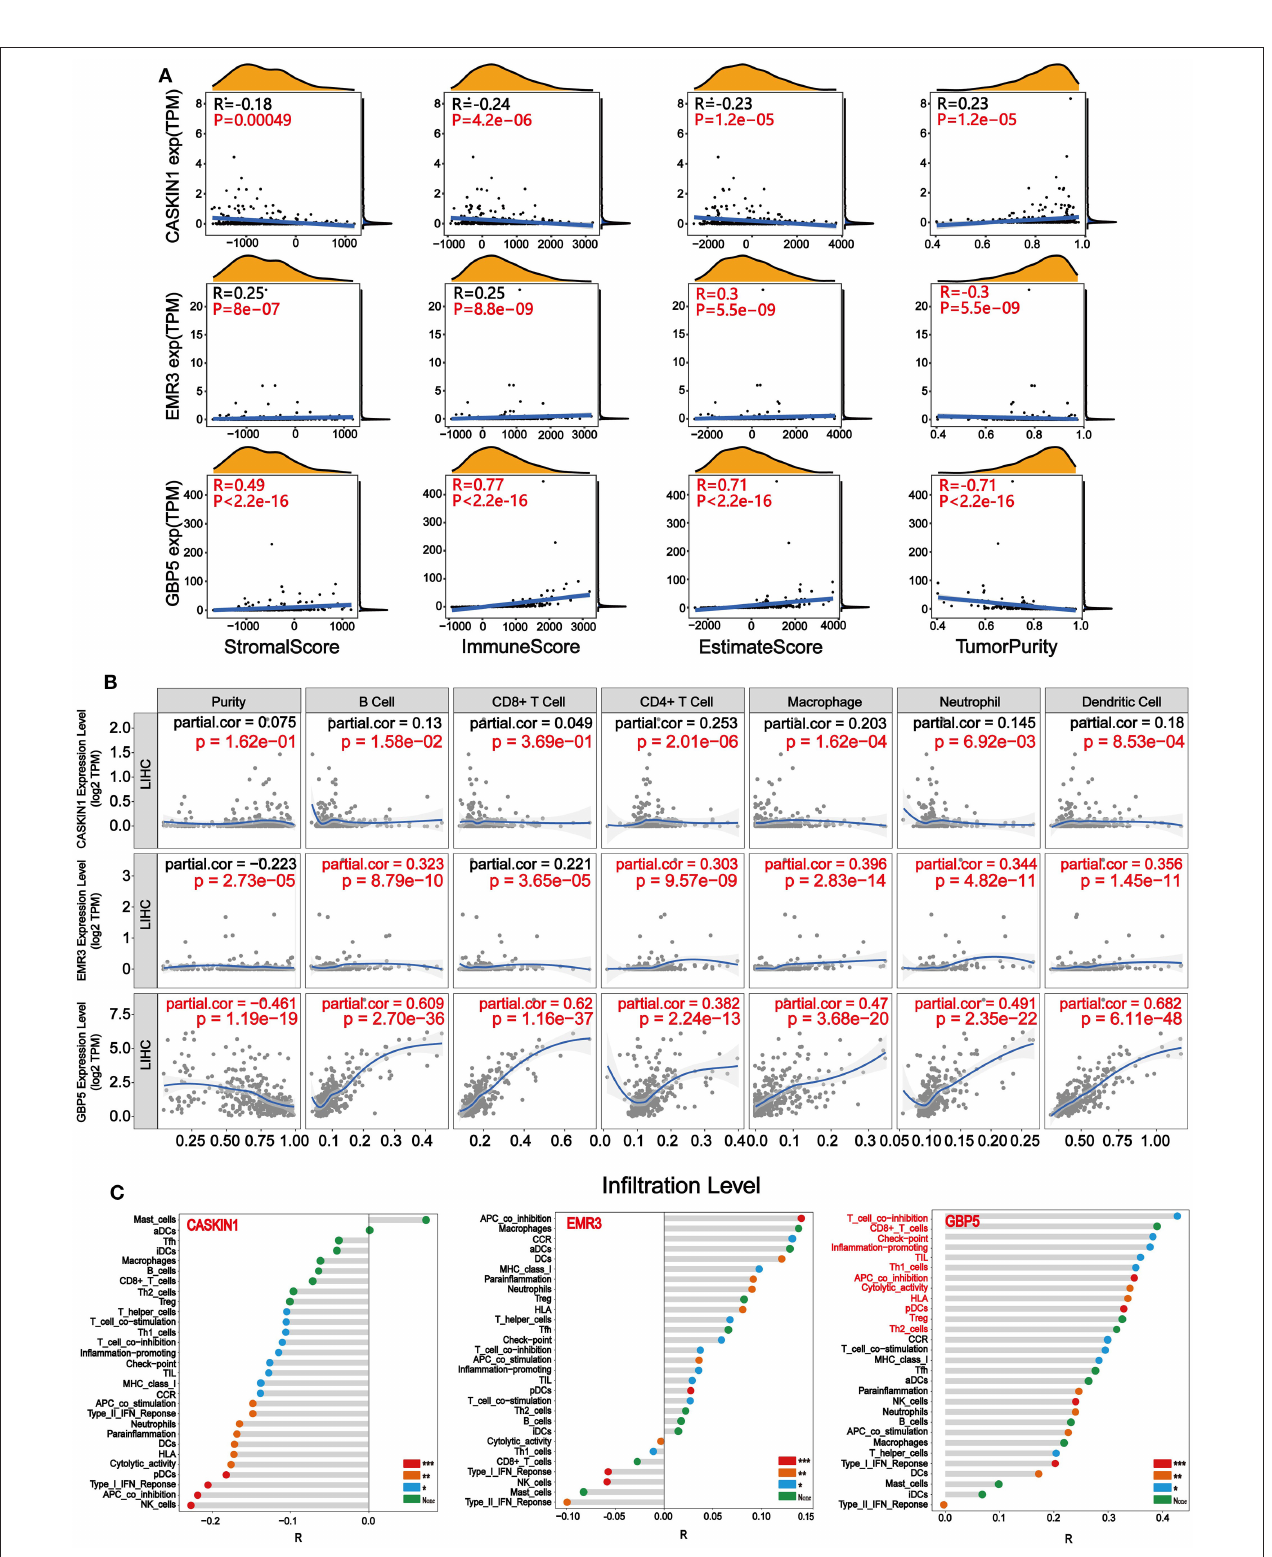
FIGURE 6 | Immune infiltration related to CASKIN1, EMR3, and GBP5. (A) Correlation analysis between CASKIN1, EMR3, and GBP5 mRNA expression levels and immune/stromal/Estimate scores and tumor purity in hepatocellular carcinoma (HCC). (B) The relationship between the CASKIN1, EMR3, and GBP5 gene